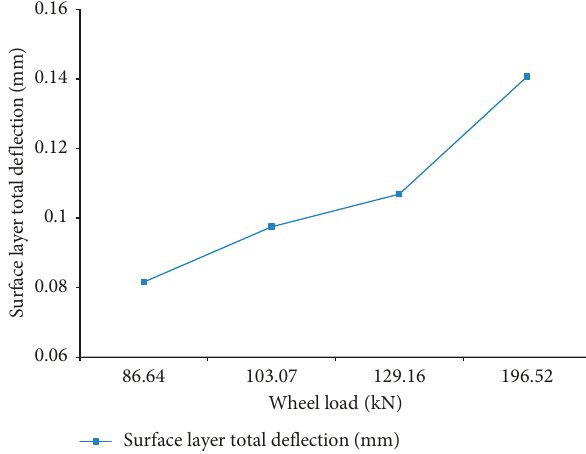
Figure 9: Maximum total defection values of each measuring point.